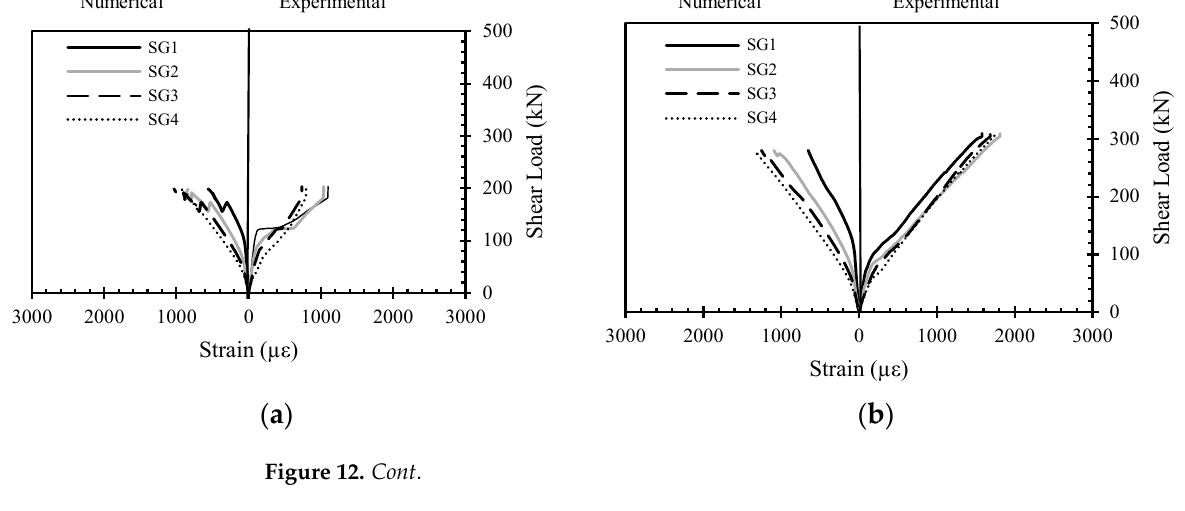
( f ) ( g ) Figure 12. Numerical and experimental steel strain responses of group S: ( a ) SR0-SF0; ( b ) SR0-SF0- S; ( c ) SR100-SF0; ( d ) SR100-SF0-S; ( e ) SR100-SF1; ( f ) SR100-SF2; and ( g ) SR100-SF3. 4.2. Deep Beam Models with Openings